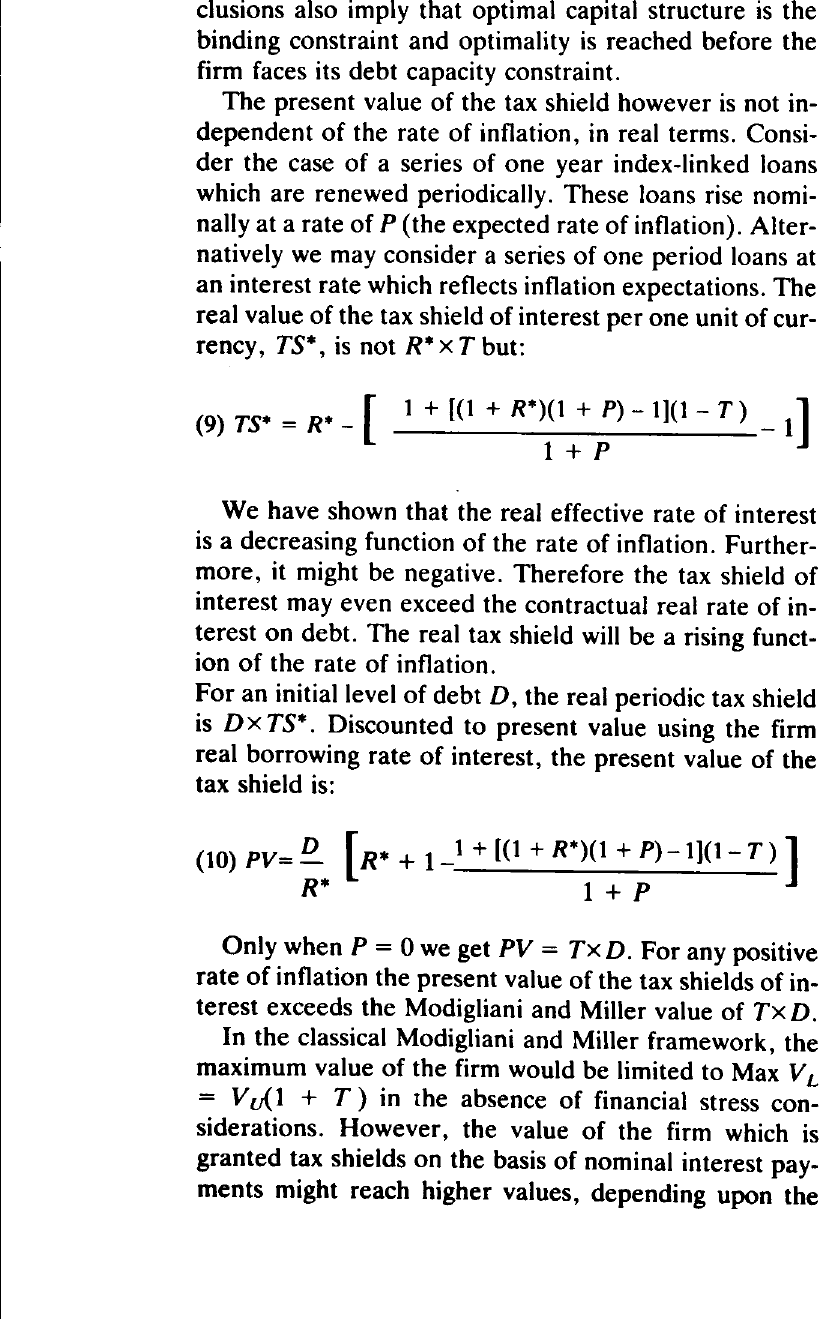
Figure 3 Optimal capital structure for alternative inflationary